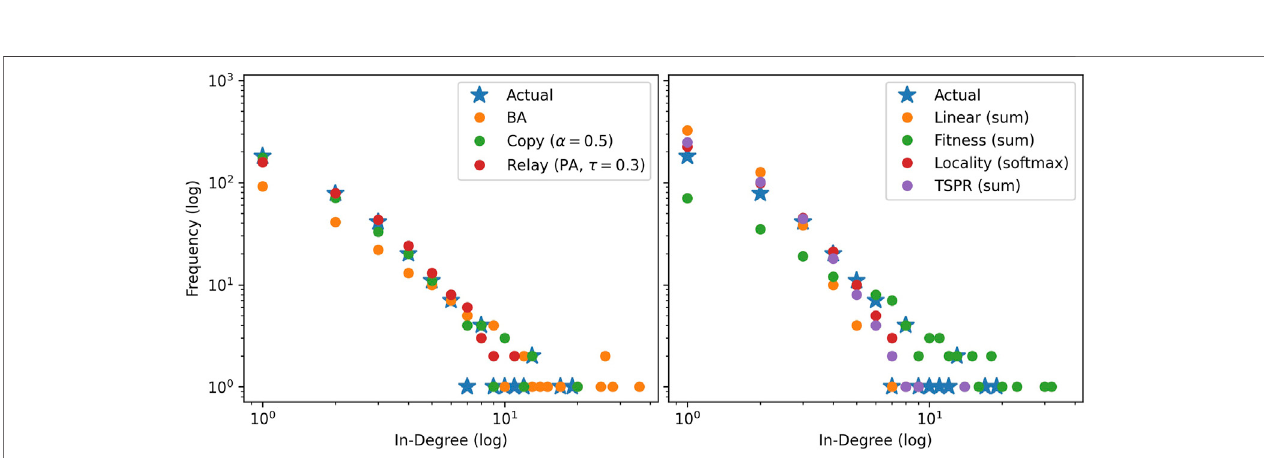
FIGURE 4 | Mode-averaged in-degree distributions for SGCA-calibrated baselines (left) and subject models (right) relative to the actual. Mirroring the actual network, 50 iterations of 1000 node steps are run per model. Models in the same iteration use identical, pre-drawn out-degree counts from | E n | ∼ Po ( 0 . 778 ) and subjects from ϕ ∼ Dir ( ψ sg , 31 ) .